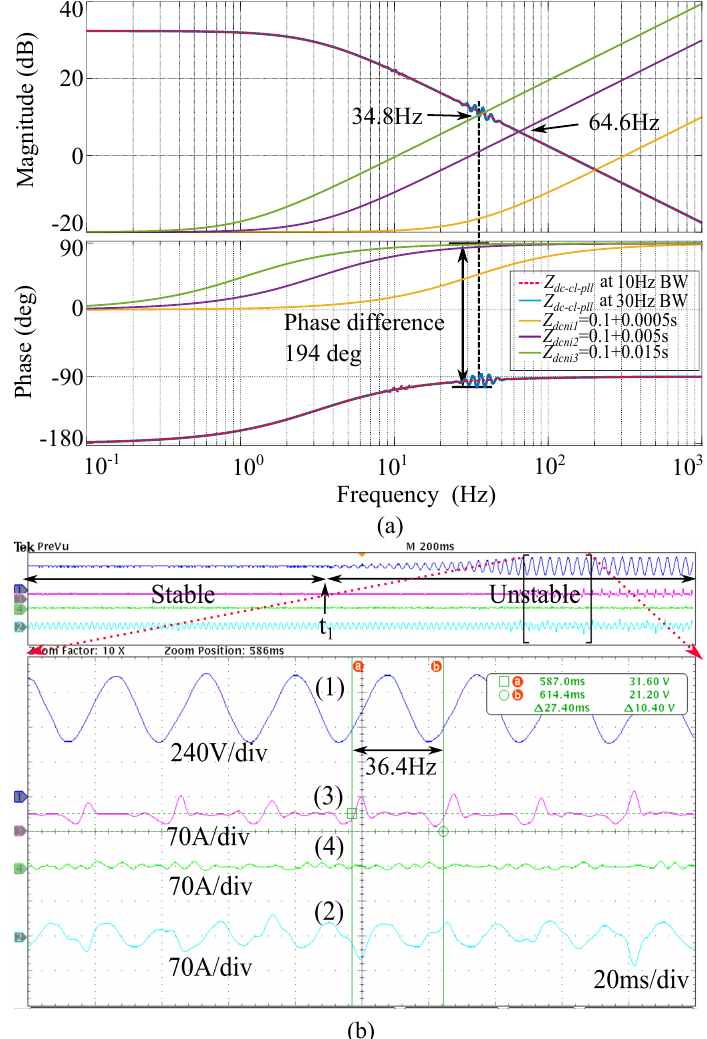
Figure 9. The converter is operating in closed loop dq current control mode. ( a ) A Bode plot shows the DC impedance model characteristics with different DC network impedances, ( b ) test result with DCNI: (1) DC link voltage, (2) grid current, (3) d -axis actual current, (4) q -axis actual